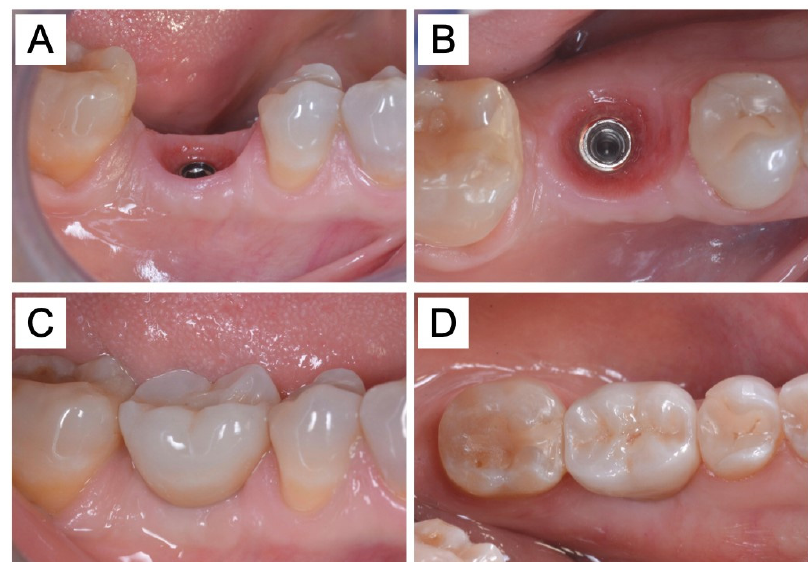
Figure 17. Cement-retained final single crown. ( A ) Peri-implant soft-tissue conditioning and maturation (buccal view). ( B ) Peri-implant soft tissues conditioning and maturation (occlusal view). ( C ) Cement-retained monolithic zirconia crown (buccal view). ( D ) Cement-retained monolithic zirconia crown (occlusal view).